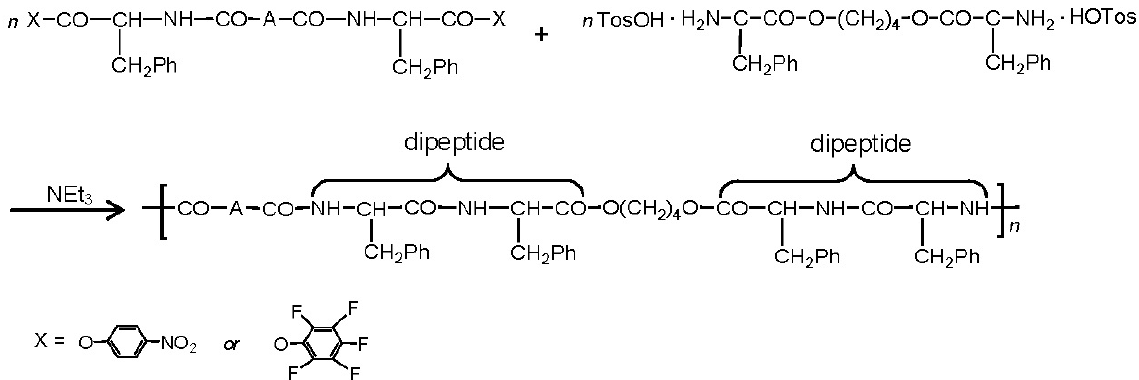
Figure 40. Synthesis of dipeptide-containing